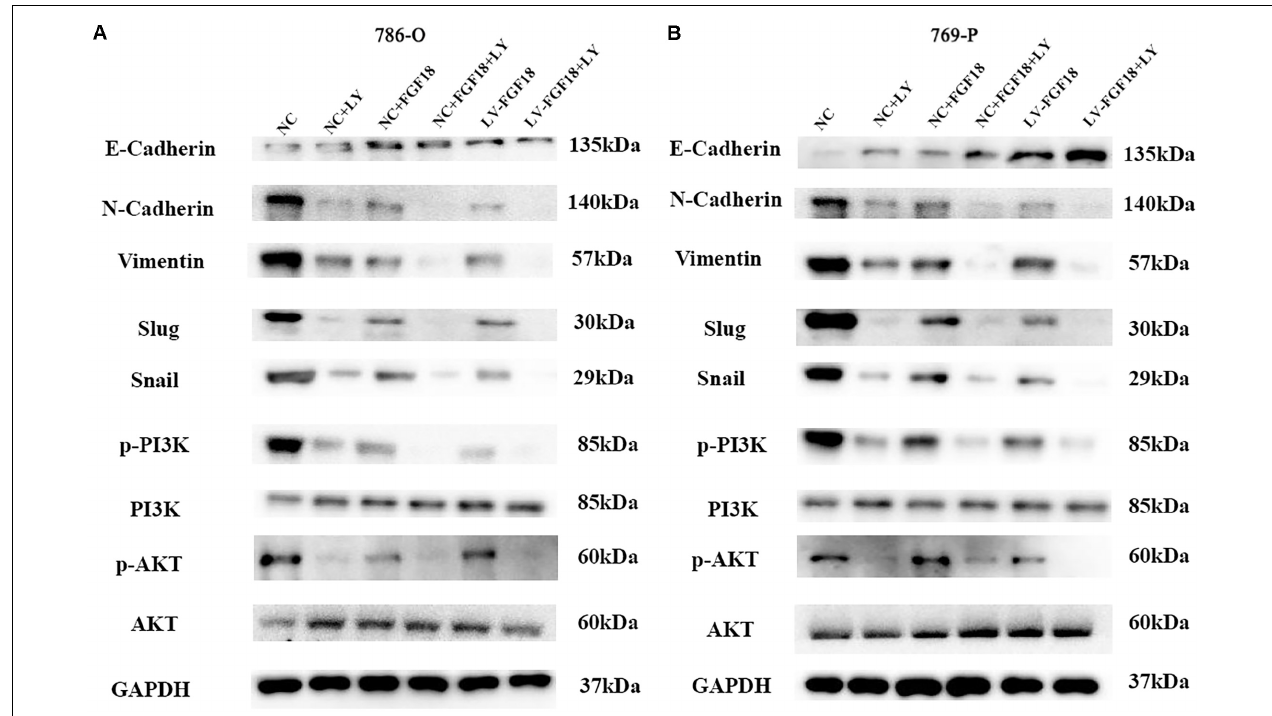
FIGURE 9 | Inactivation of the PI3K/AKT pathway enhances the EMT inhibitory effect of FGF18 in ccRCC cell lines. (A) 786-O cells treated with LY294002 (10 µ M) or recombinant FGF18 (100 ng/ml) and FGF18 overexpressed 786-O cells treated with LY294002 were incubated for 12 h for WB analyze. (B) 769-P cells treated with LY294002 (10 µ M) or recombinant FGF18 (100 ng/ml) and FGF18 overexpressed 786-O cells treated with LY294002 were incubated for 12 h for WB